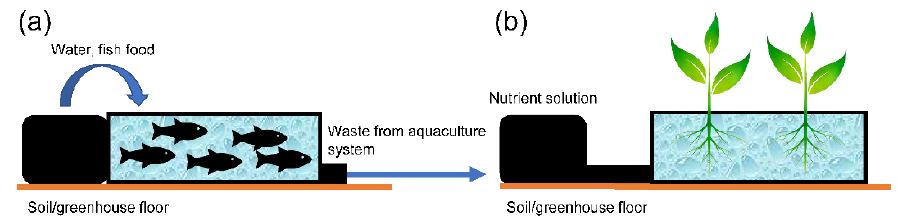
Figure 4. Aquaponic system consisting of an ( a ) aquaculture system for fish production, which is connected to a ( b ) hydroponic system used for crop production.